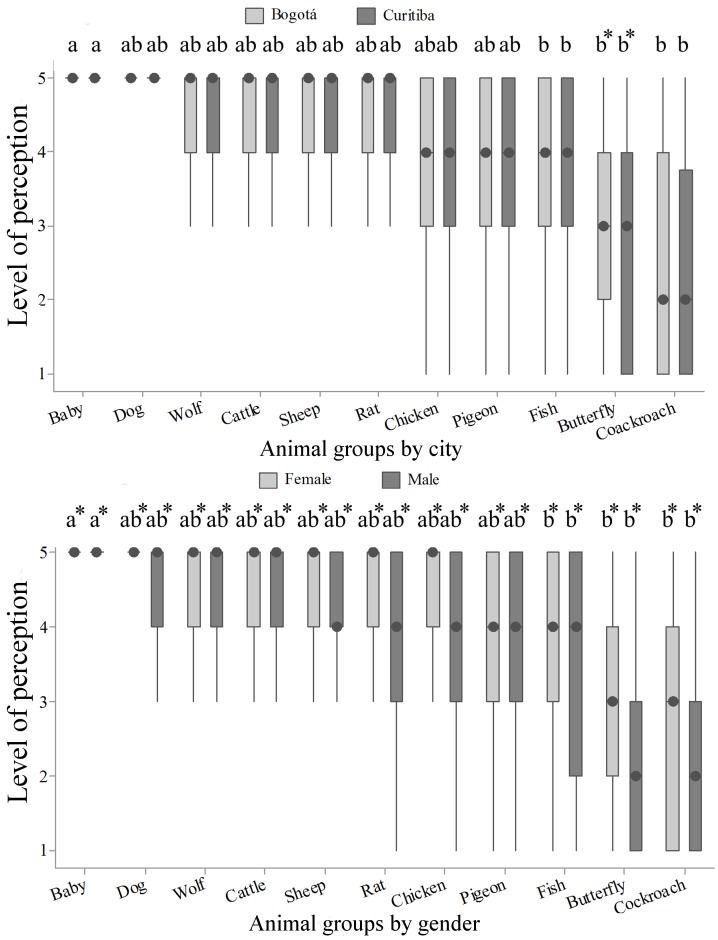
Perception of animal sentience (Q2) by 782 citizens of Bogotá and Curitiba, 2014/2015.Data for city and gender; 1 = no sentience and 5 = maximum sentience; the asterisk indicates both city and gender difference (P<0.05, Mann-Whitney); letters indicate differences between animals (P<0.05, Kruskal-Wallis and Dunn Test).